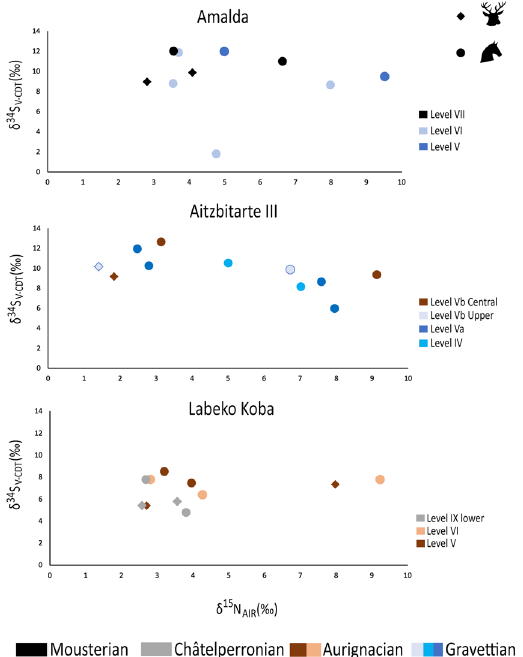
Figure 7. Red deer and horse δ 34 S values plotted with the δ 15 N ones for Aitzbitarte III, Labeko Koba and Amalda showing the distribution of values for each archaeological level and cultural period. Red deer are plotted as circles and horses are plotted as